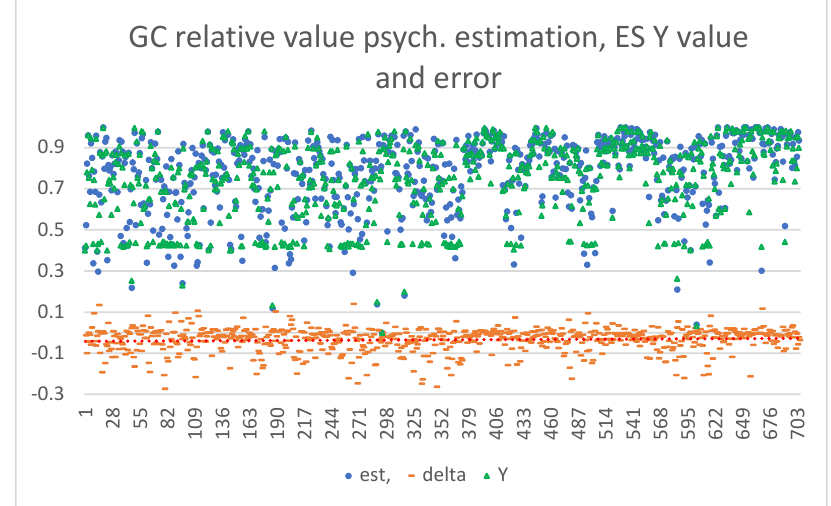
Figure 12. Example of comparison between psychologist-based evaluation and ES-based prediction with delta (difference). Table 11. Differences (delta) between psych. evaluation and ES values (descriptive statistics).